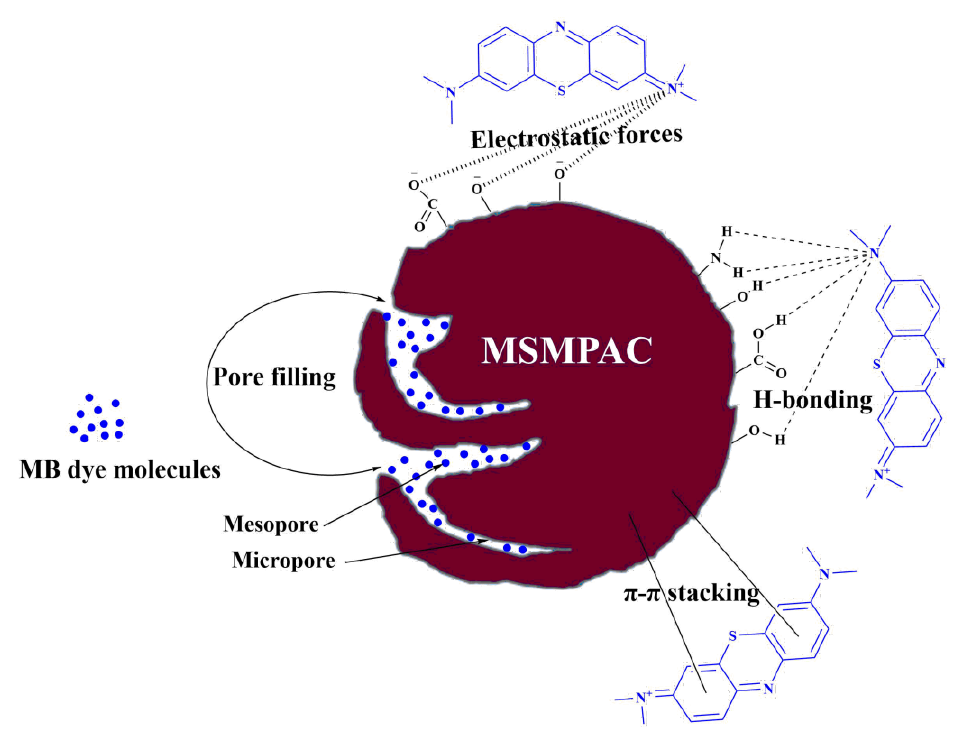
Figure 9. Schematic representation of potential interactions between MSMPAC and MB, including electrostatic forces, pore filling, hydrogen bonding, and π - π stacking . electrostatic forces, pore filling, hydrogen bonding, and π - π